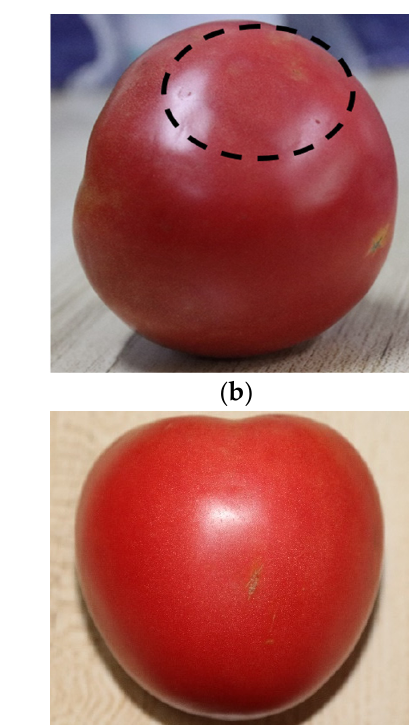
Figure 14. Test platform of the net bag mechanism.